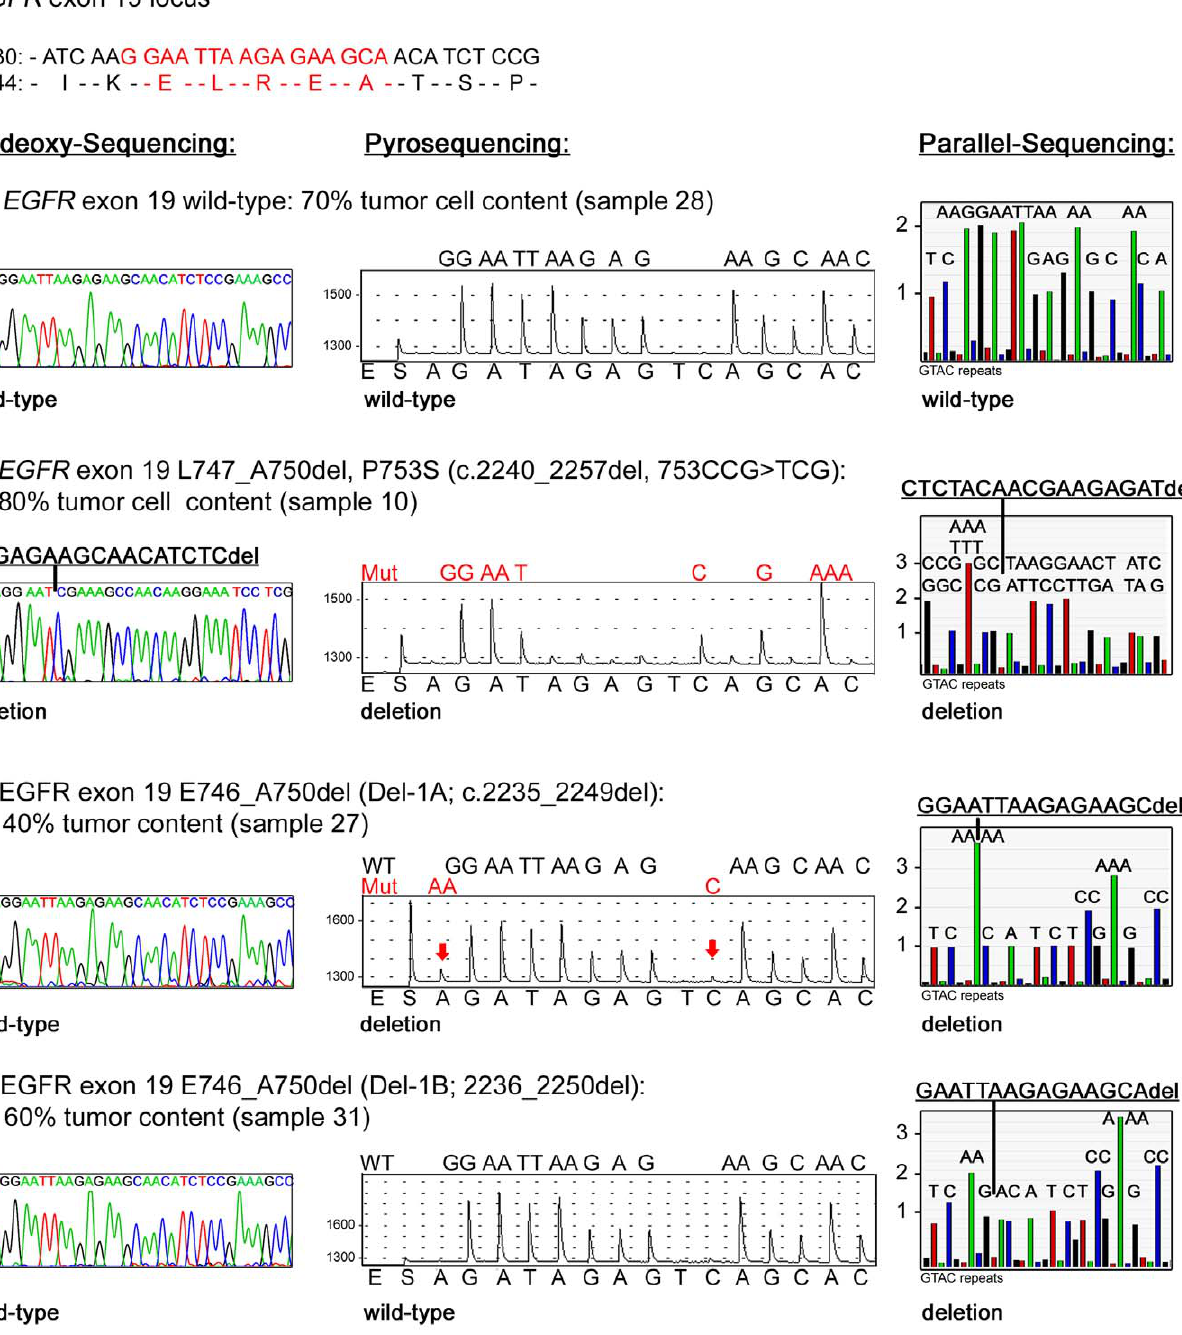
Figure 1. EGFR exon 19 mutation analysis in NSCLC tumor samples. Sequencing analysis of EGFR exon 19 was performed by dideoxy sequencing (electropherograms in the left panels), pyrosequencing (pyrogams in the middle panels) and massively parallel sequencing (programs in right panel). (A) Wild-type EGFR exon 19 detected by all three sequencing techniques; (B) L747_A750del, P753S mutation detected by all three sequencing techniques; (C) E746_A750del (Del-1A) mutation identified by pyrosequencing and massively parallel sequencing; (D) E746_A750del (Del- 1B) only detected by massively parallel sequencing. del, deletion; Mut, mutation; WT, wild-type. Arrows indicate position of expected mutation specific signals. doi:10.1371/journal.pone.0019601.g001 tumor-cell content ( r 2 = 0.27, p = 0.029). Remarkably, the detec- ry Figs. S2, S3, S4, S5, S6, S7, S8, S9, S10 ): 29% for dideoxy tion limits of the different approaches determined by counting of sequencing and 11% for pyrosequencing ( Table 1 and Fig. 2A ). mutant and wild-type alleles detected by massively parallel The allele frequencies of mutations found by pyrosequencing but sequencing in the primary tumors were highly similar to those not dideoxy sequencing ranged between 11% and 21% ( Fig. 2A ). observed in the initial allele mixing experiments ( Supplementa-